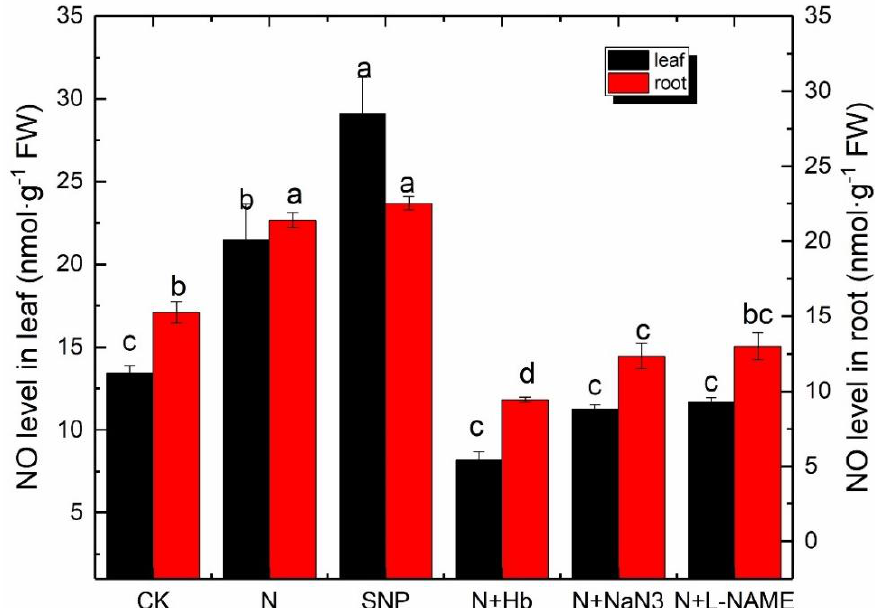
Figure 6. Effects of different ammonium/nitrate ratios, exogenous nitric oxide, and the addition of NO scavenger and biosynthesis inhibitors in ammonium/nitrate solution on NO levels of leaf and root in mini Chinese cabbage exposed to low − light stress. Data represented means, and bars indicated the standard errors of the means ( n = 3). Significant differences ( p ≤ 0.05) between treatments were indicated by different letters, according to Tukey’s test.